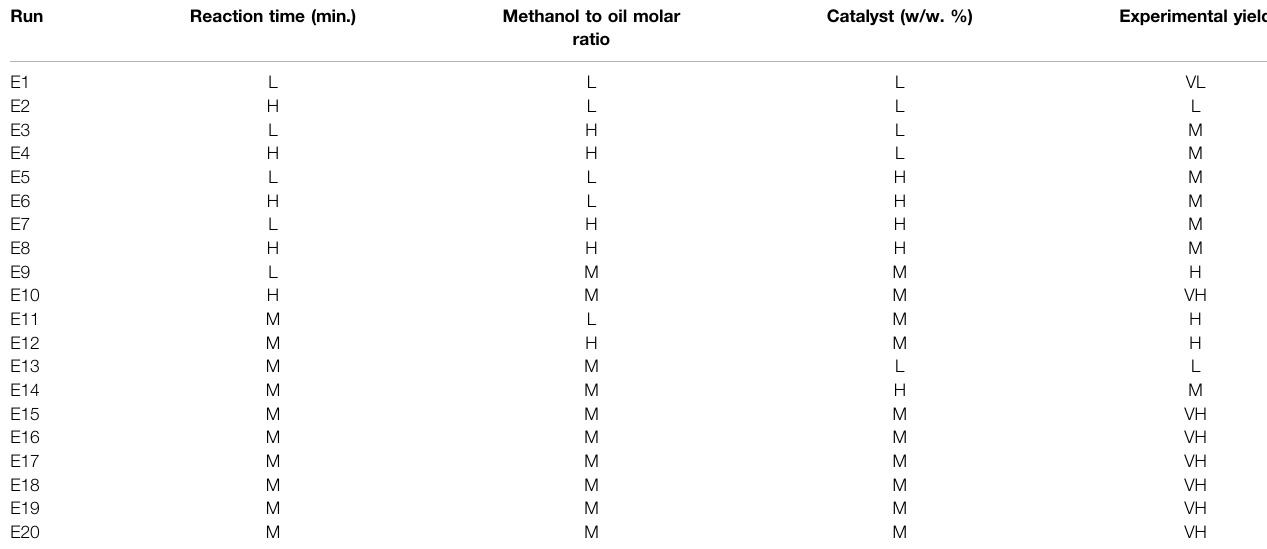
TABLE 3 | Rule base of fuzzy inference system. Run Reaction time (min.)